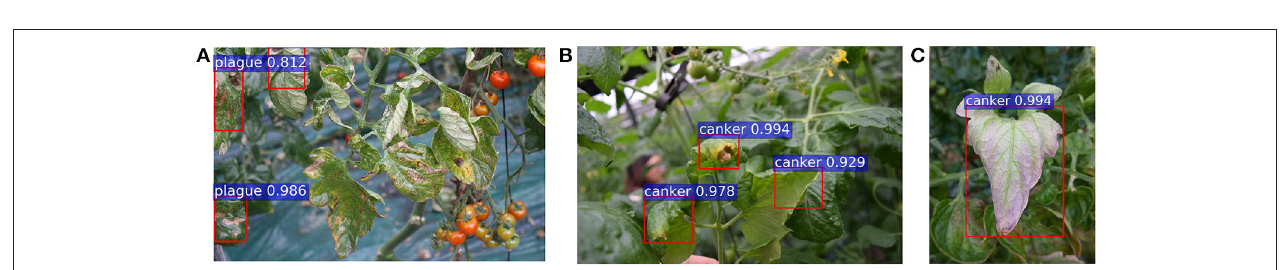
FIGURE 5 | A representation of some false positives generated in the primary diagnosis unit: (A) canker samples are detected as plague; (B) gray mold samples are detected as canker; (C) a low temperature sample is detected as canker.